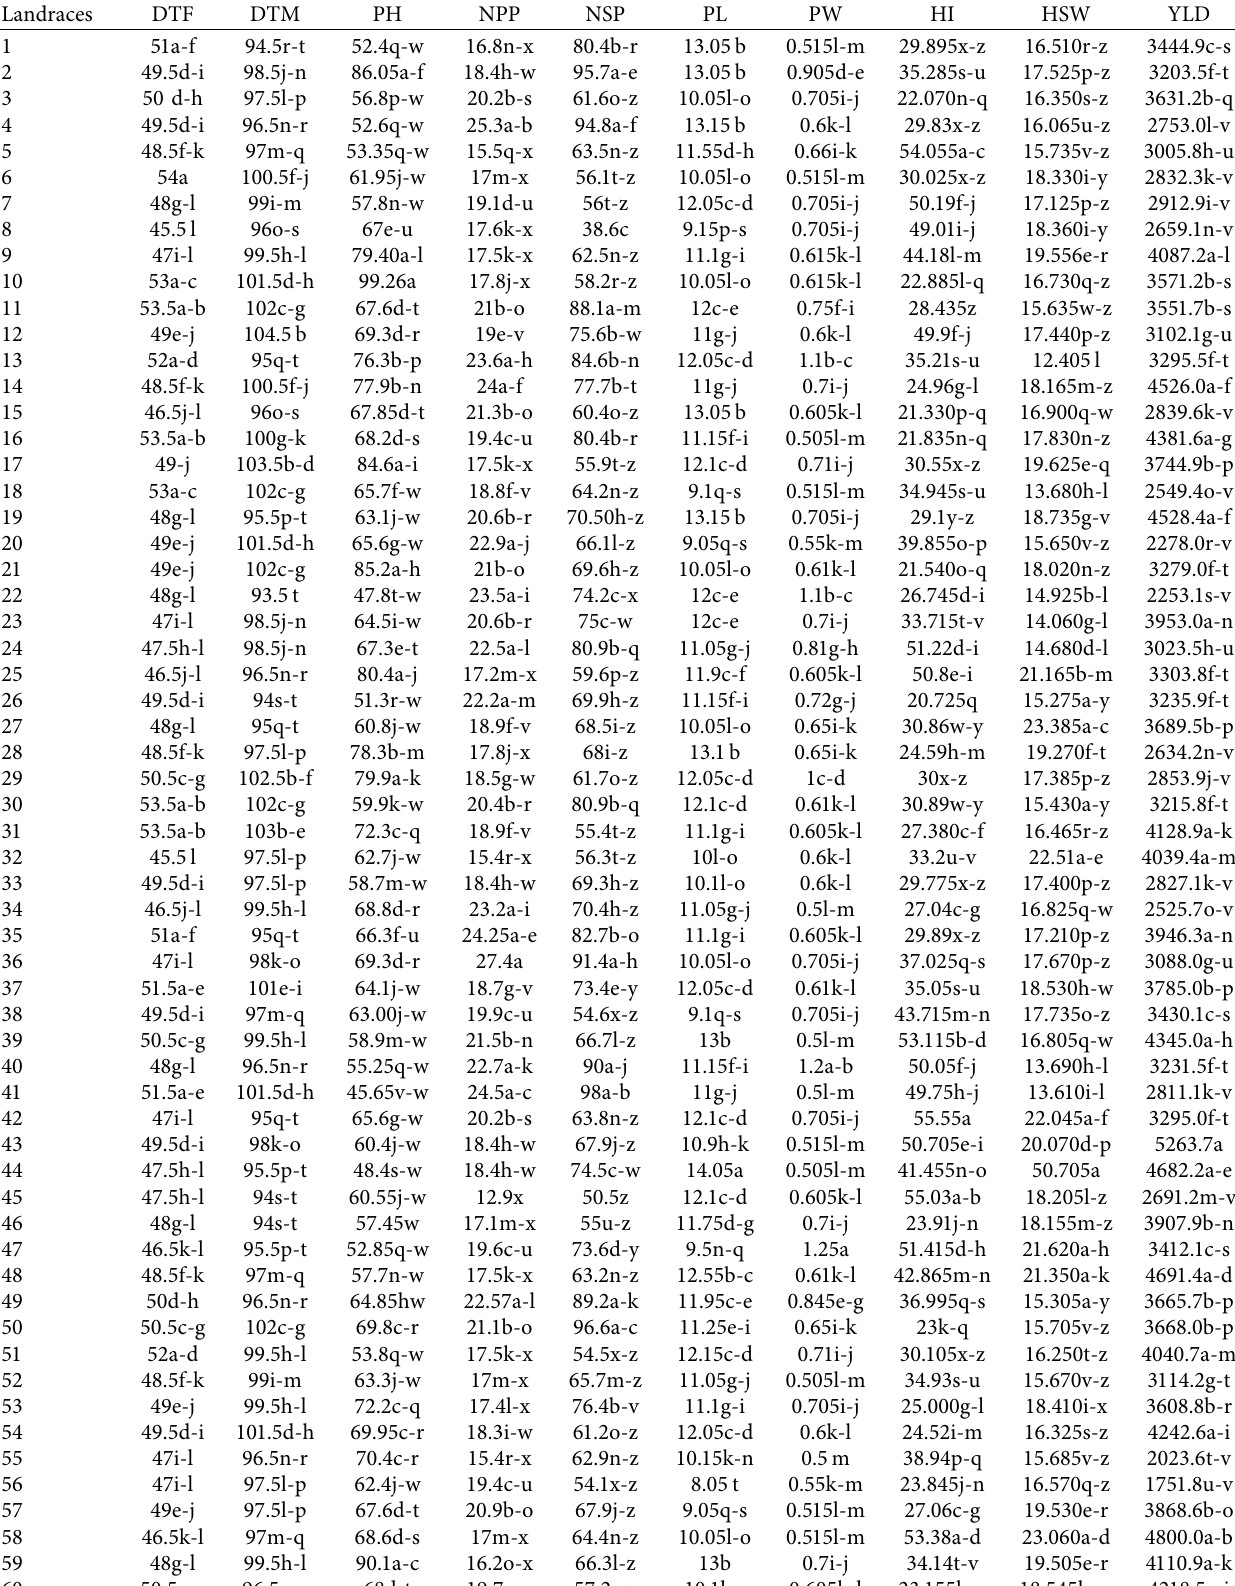
Table 4: Mean performance of one hundred genotypes tested at Jimma during